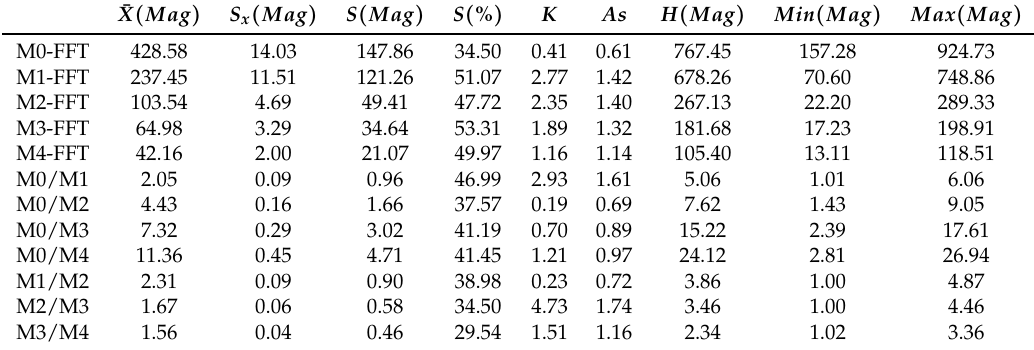
Table A8. Statistical descriptive measures of the data without outliers by magnitude measurement of the standard group of C. capitata